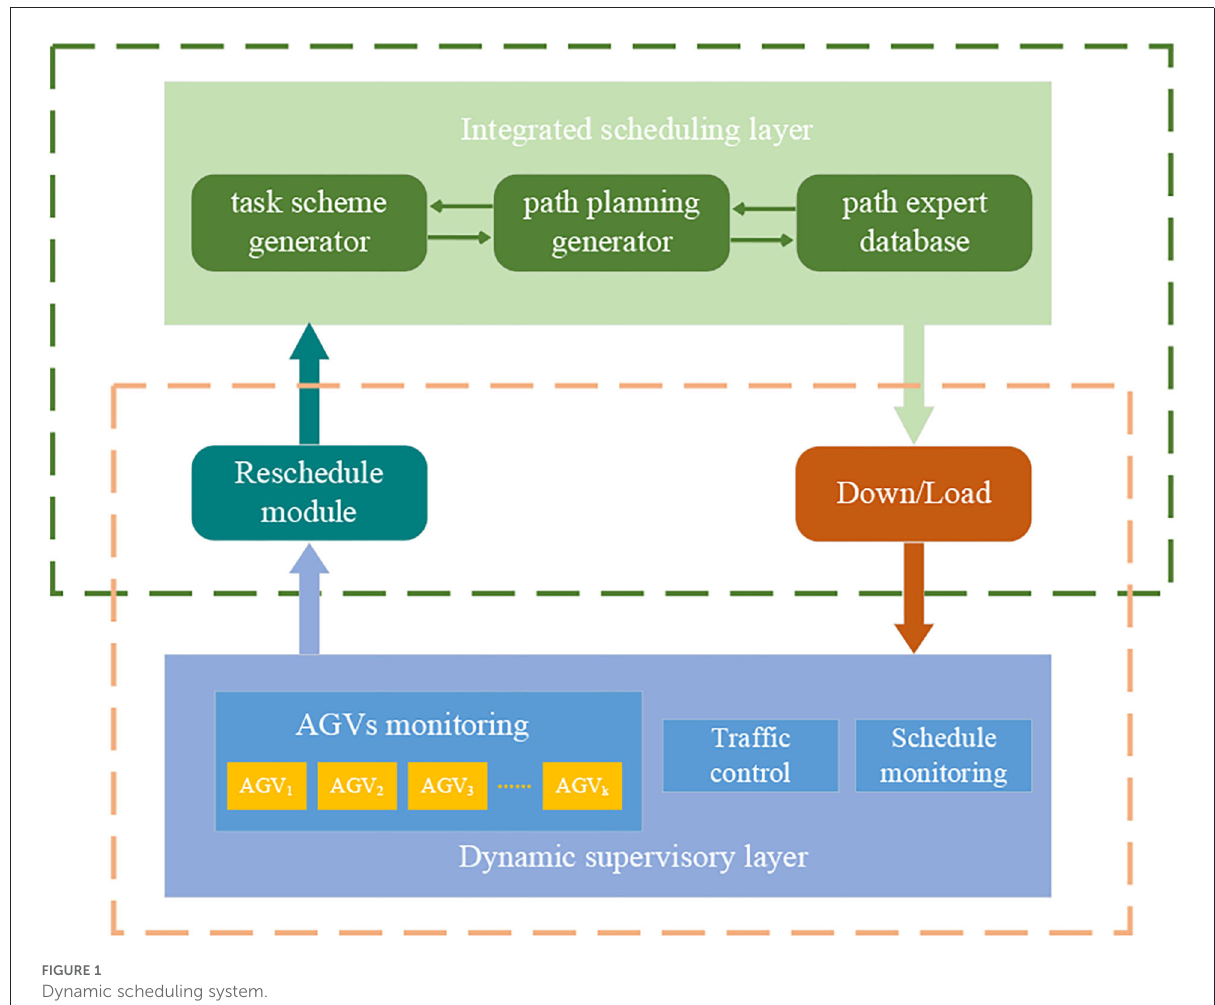
FIGURE1 Dynamic scheduling